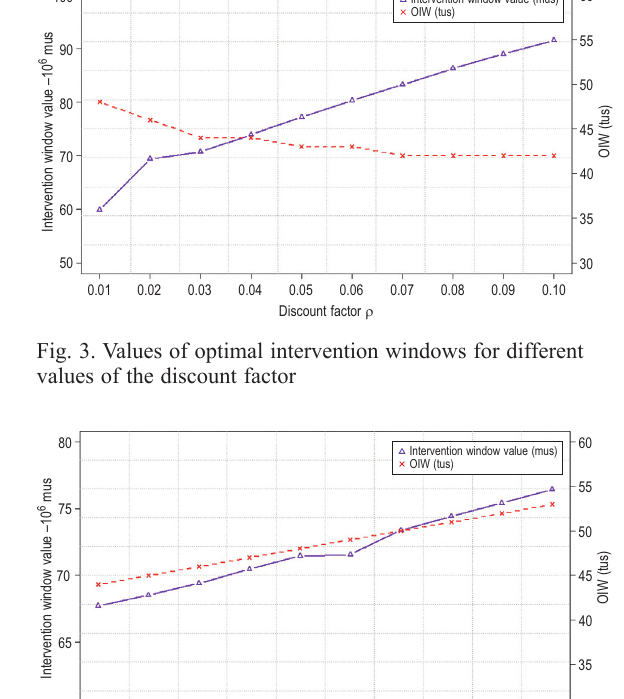
Table 4. Ranges of values used in the sensitivity analysis Minimum Maximum Fig. 4. Values of optimal intervention windows for different Percentage Percentage values of the drift parameter Parameter Value of initial Value of initial estimate estimate ρ 1% N/A 10% N/A µ 0.0001 –85 0.01 +85 σ 0.10 –70 0.60 +70